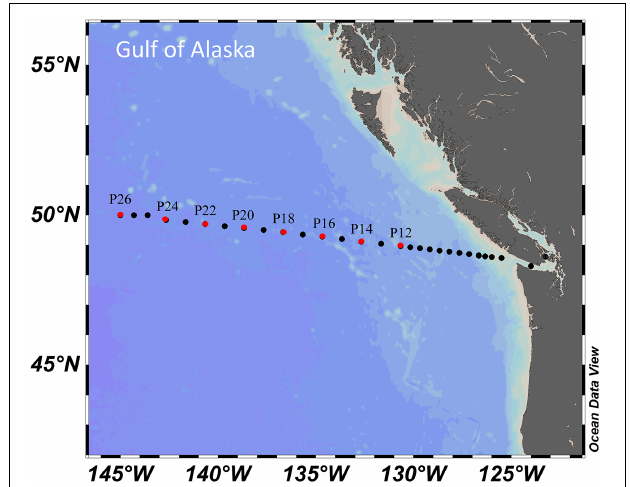
FIGURE 1 | Locations of Line P stations; those considered in this analysis are highlighted in red. This figure was created using Ocean Data View (Schlitzer,